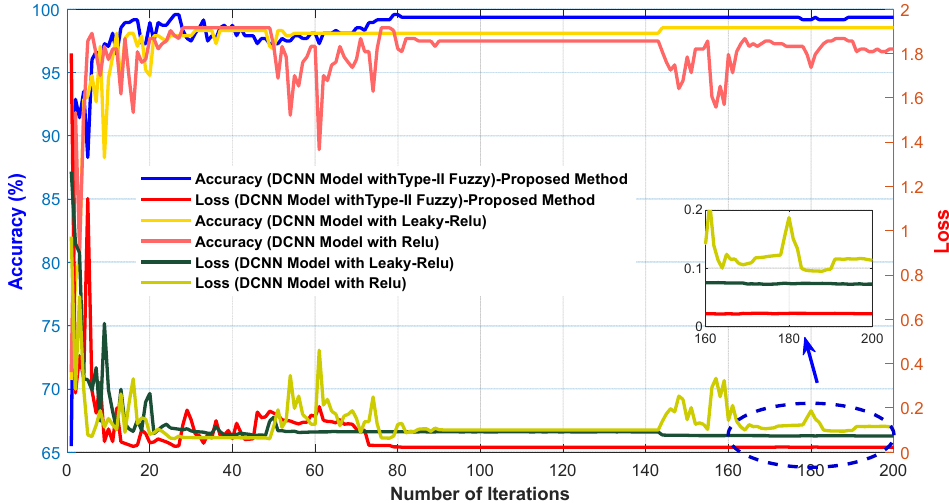
Figure 7. The accuracy and error diagrams of the proposed method based on the DCNN model with type-II fuzzy activation function, compared to the DCNN model with Relu and Leaky-Relu activation functions.